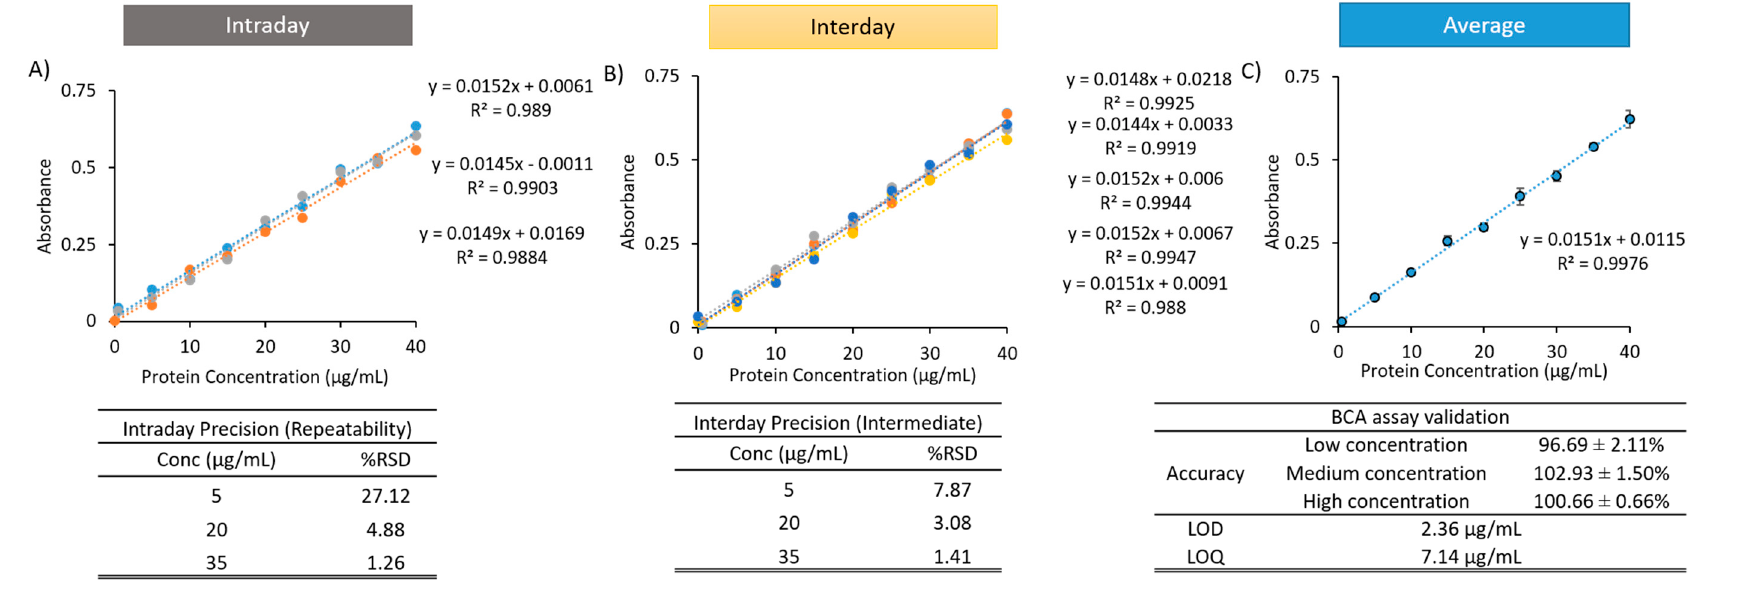
Figure 4. Ovalbumin calibration curves in water in the presence of liposomes (prepared as per Figure 3) and the addition of solubilisation mixture (50/50 v / v IPA/water). The LOD and LOQ values were established using micro BCA. Intraday curves were generated ( A ) within the same day, while Interday curves were generated over 5 separate days ( B ) along with the average ( C ). Accuracy was determined at three concentrations, while Intra-day and Inter-day precision was calculated across three different concentrations with, %RSD shown.